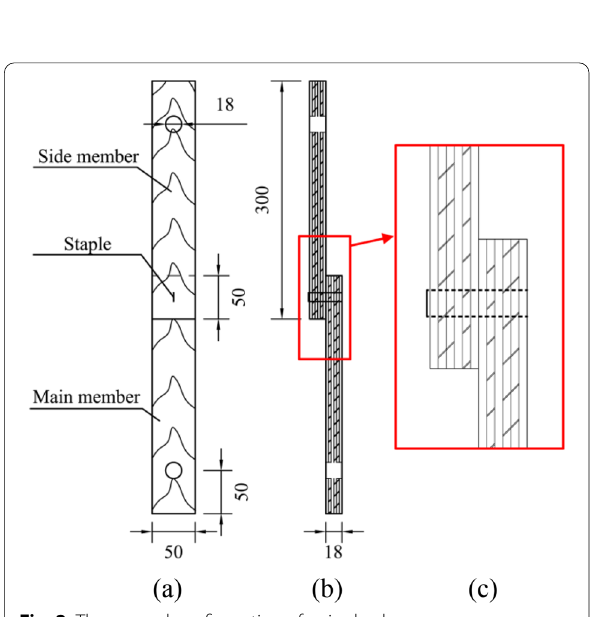
Fig. 2 The general configuration of a single-shear plywood-to-plywood single-staple connection a front view, b side view, and c enlarged diagram showing details at the connection (unit: mm)